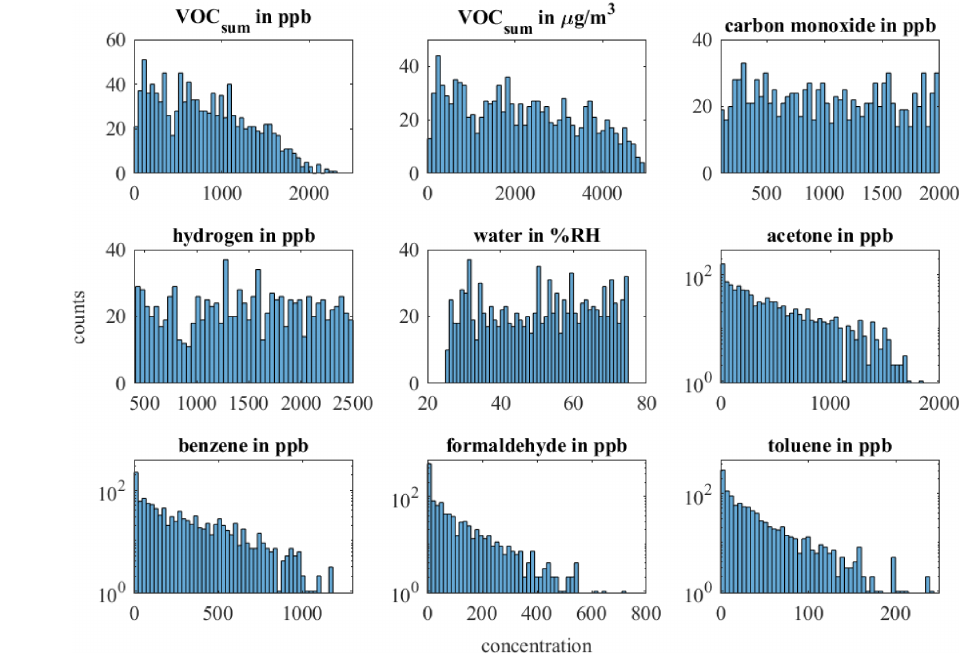
Figure A1. Concentration histogram of the observations in the complete measurement campaign for all gases and VOC sum .